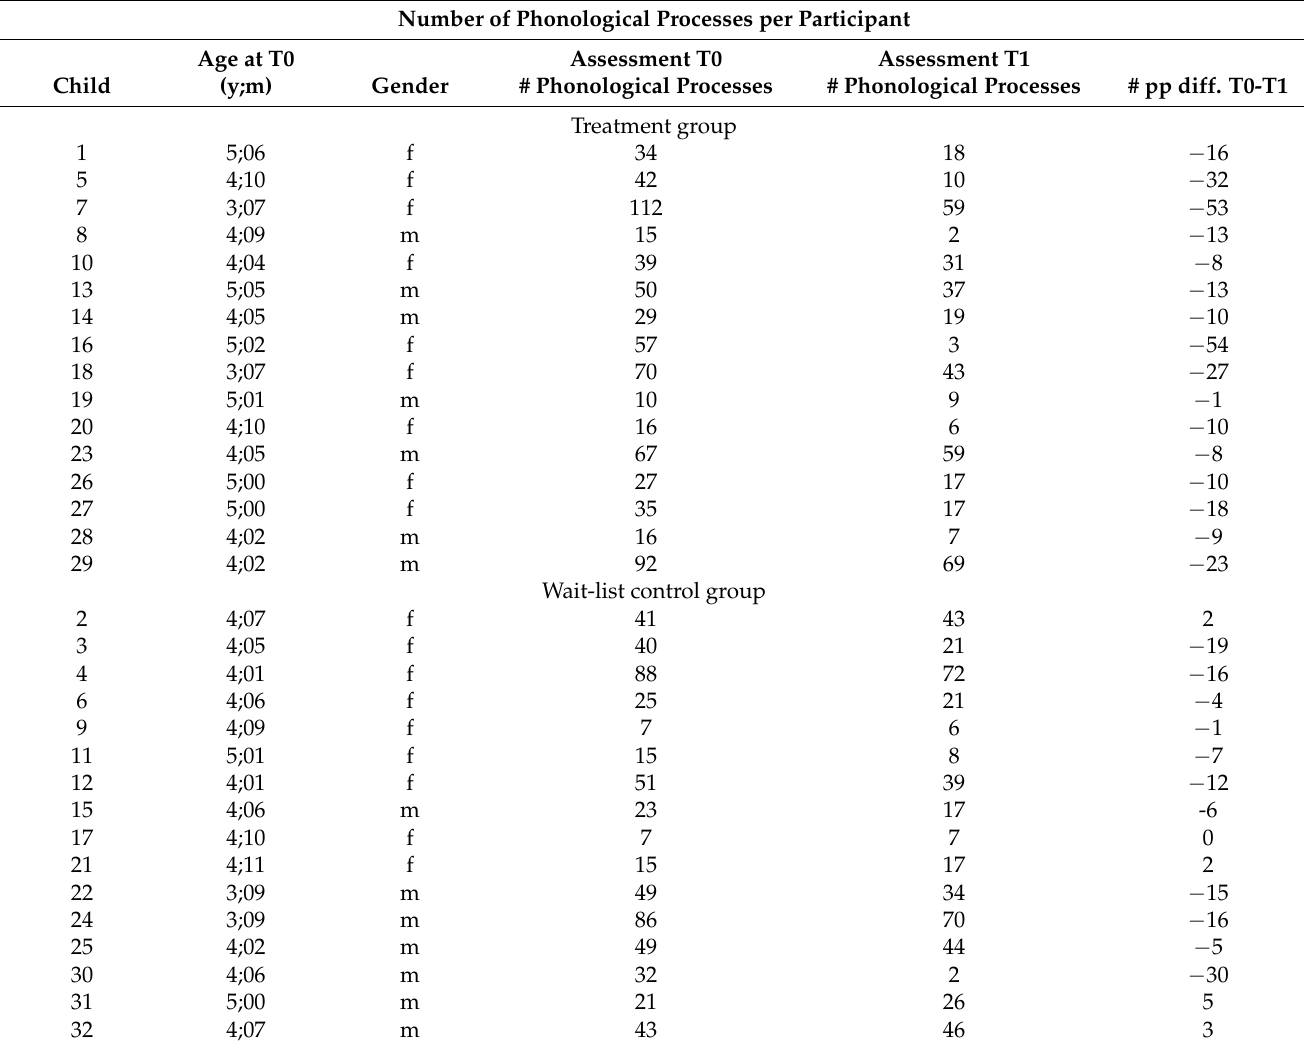
Table 3. Number of phonological processes per participant. Their change from T0 to T1 is given in column # pp diff. T0–T1. Number of Phonological Processes per Participant Age at T0 Assessment T0 Assessment